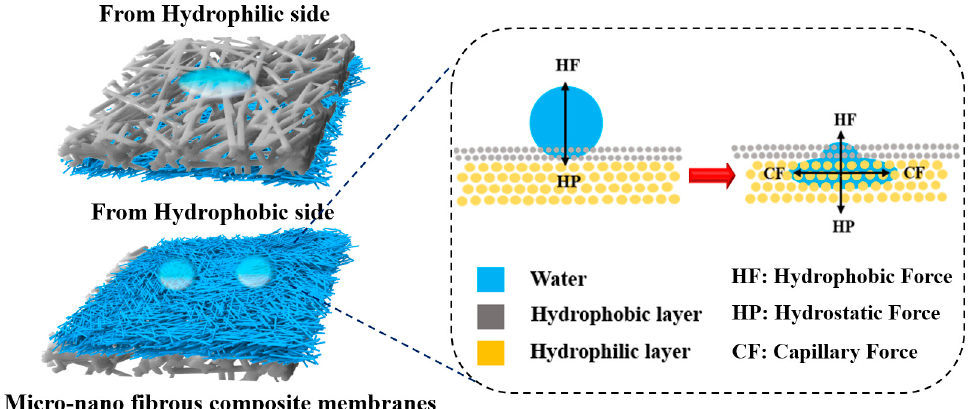
Figure 10. Schematic illustration of the water on the micro-/nano-fibrous composite membranes.